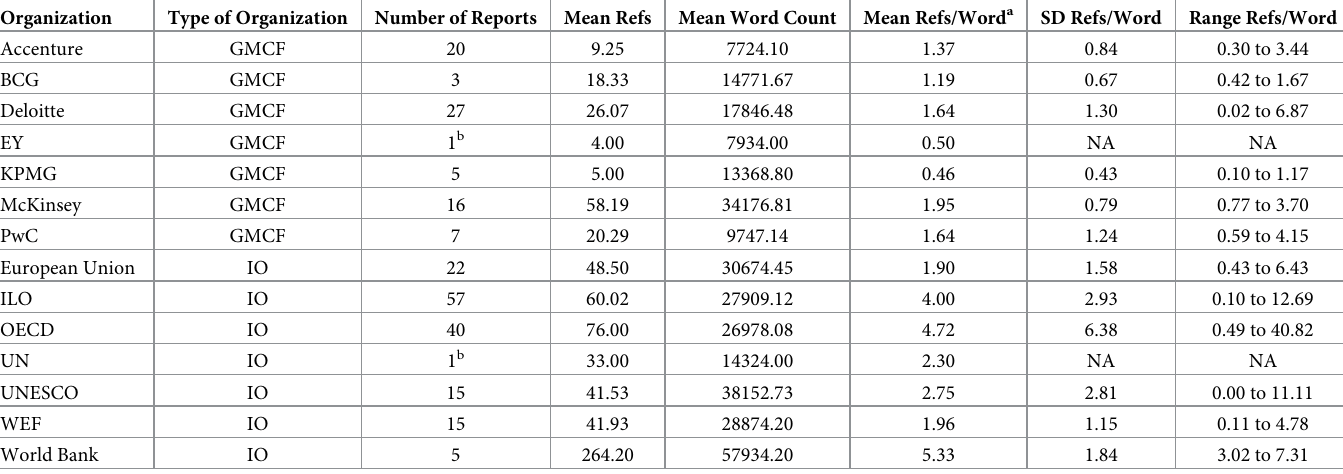
Table 1. Descriptive data on reference-rates across